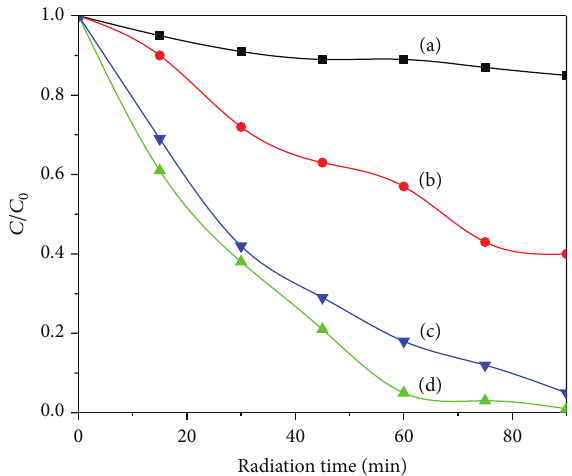
Figure 9: Degradation curve of methyl orange: (a) self-degradation of methyl orange, (b) ZnO/BC hybrid fibers, (c) ZnO/CdS, and (d) ZnO/CdS/BC hybrid fibers